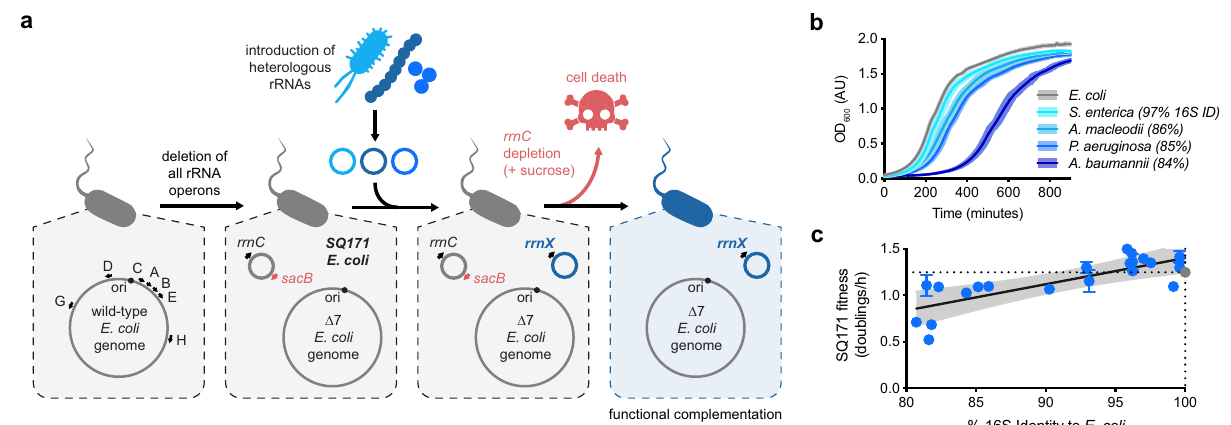
Fig. 1 Assessment of heterologous rRNA activity via SQ171 complementation. a Schematic representation of the SQ171 complementation assay. SQ171 E. coli cells lack all 7 genomic ribosomal RNA (rRNA) operons and maintain a single rrnC operon on a SacB counter-selectable plasmid. Introduction of a heterologous rRNA ( rrnX ) and depletion of the E. coli rrnC plasmid using sucrose yields cells that rely upon the heterologous ribosome for survival. b Growth time course of SQ171 cells bearing increasingly divergent heterologous rRNAs ( n = 2-8). c Correlation between heterologous 16S rRNA sequence identity to E. coli (%) and SQ171 fi tness (doublings/h) upon complementation (99% CI, R 2 = 0.62). E. coli rRNA control plotted in gray. Data represent the means of 1 – 8 biological replicates; error bars represent standard deviations for conditions with 3 or more replicates. Complete SQ171 complementation data (including precise number of replicates) are reported in Supplementary Table 1. OD optical density, AU arbitrary units, h hour. Source data are available in the Source Data